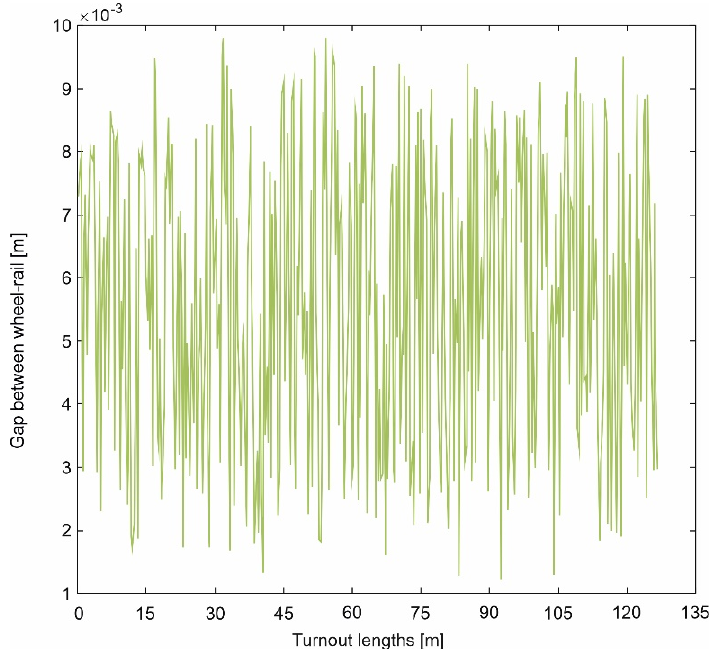
Figure 8. The gap between a wheel -rail of the railway turnout.